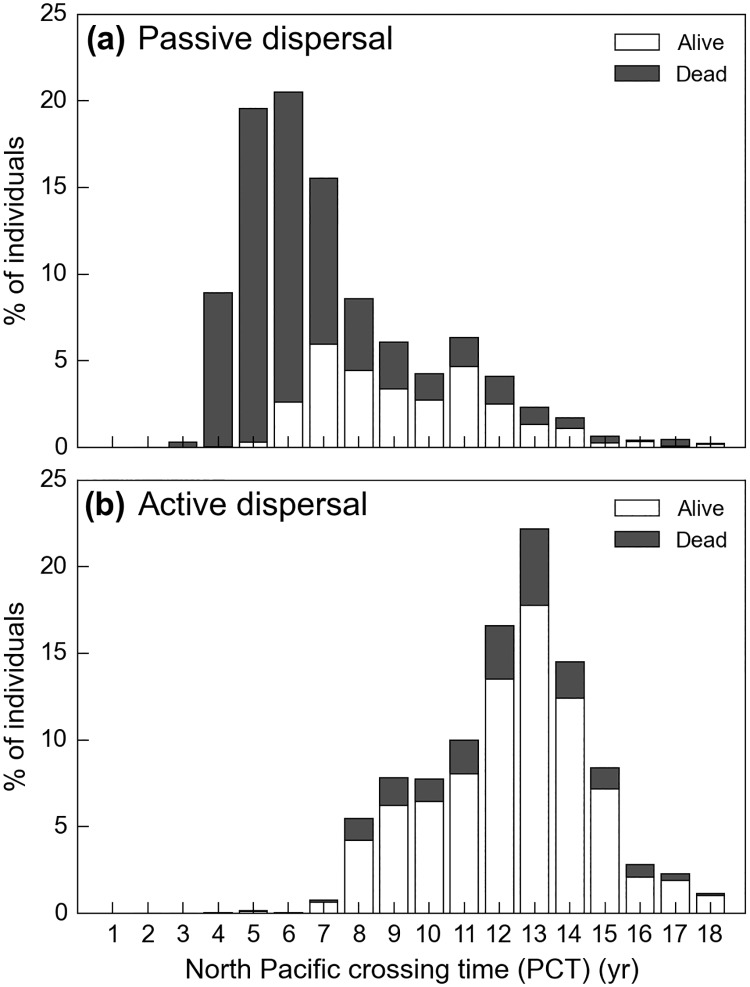
Histogram of the North Pacific crossing times (PCT) for (a) passive and (b) active turtles.